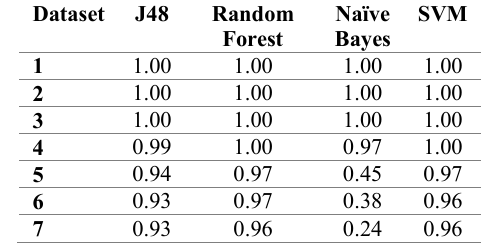
Table 6. Confusion matrix for